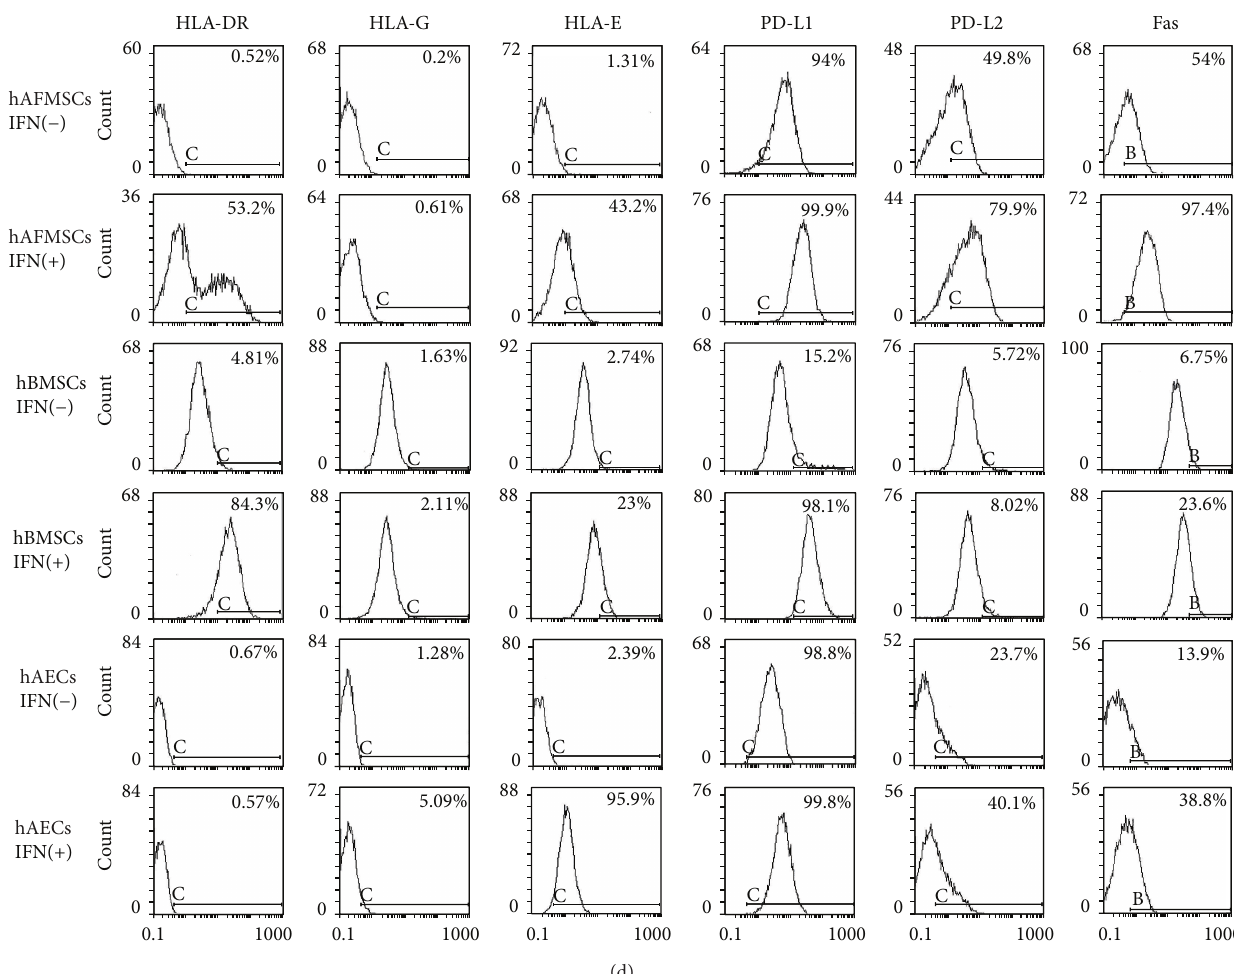
Figure 1: hAECs show a different phenotype compared to hBMSCs and hAFMSCs. (a) hAECs exhibited an epithelial-like morphology under the light microscope and scanning electron microscope, while both hAFMSCs and hBMSCs showed a spindle-shaped fibroblast morphology. (b) CCK-8 results at days 0, 2, 4, 6, 8, 10, and 12 after cell seeding revealed a significant higher proliferation activity of hAECs at day 8, 10, and 12 compared to the other two cells ( ∗ : 𝑃 < 0.05 ). Flow cytometry analysis for the basic surface makers demonstrated that all cell sources were positive for the MSC markers CD44, CD90, CD105, and lacked the expression of hematopoietic makers CD45, CD34. Moreover, hAECs expressed a higher level of CD326 and SSEA4, while hBMSCs barely expressed these markers. (c) After culturing with or without 10ng/mL IFN- 𝛾 for 5 days, expression patterns of immunologic markers in all cell types are presented as heat maps of the percentage of cells in the total population expressing the marker (see color legend). (d) Flow cytometry results for HLA-DR, HLA-G, HLA-E, PD-L1, PD-L2, and Fas were selectively shown. Nonspecific fluorescence was gated by using respective isotype-matched monoclonal-antibody